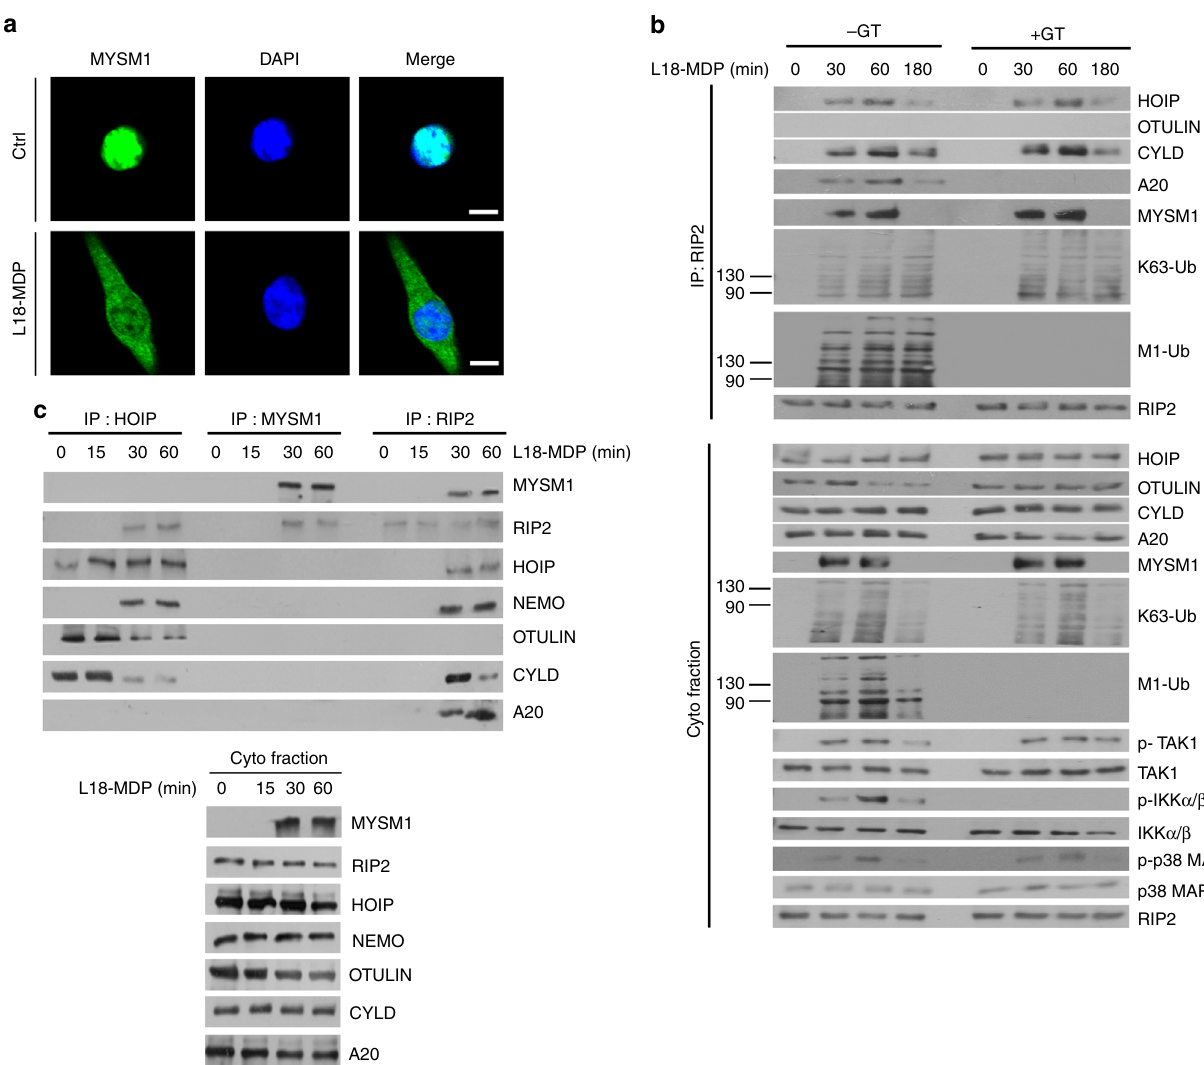
Fig. 2 MYSM1 is recruited to the NOD2:RIP2 complex independently of LUBAC. a Immuno fl uorescence staining of MYSM1 (green) in BMDMs before (Ctrl) or after 1 h stimulation with L18-MDP. Scale bar (10 µ m). b RIP2 immunoprecipitates and corresponding whole cytoplasmic fractions from WT BMDMs stimulated with L18-MDP for indicated durations in the presence or absence of gliotoxin (GT) were immunoblotted for indicated molecules. c HOIP, MYSM1, or RIP2 immunoprecipitates from WT BMDMs stimulated with L18-MDP for different durations, as well as corresponding whole cytoplasmic fractions, were examined for the presence of indicated molecules. Data are representative of three